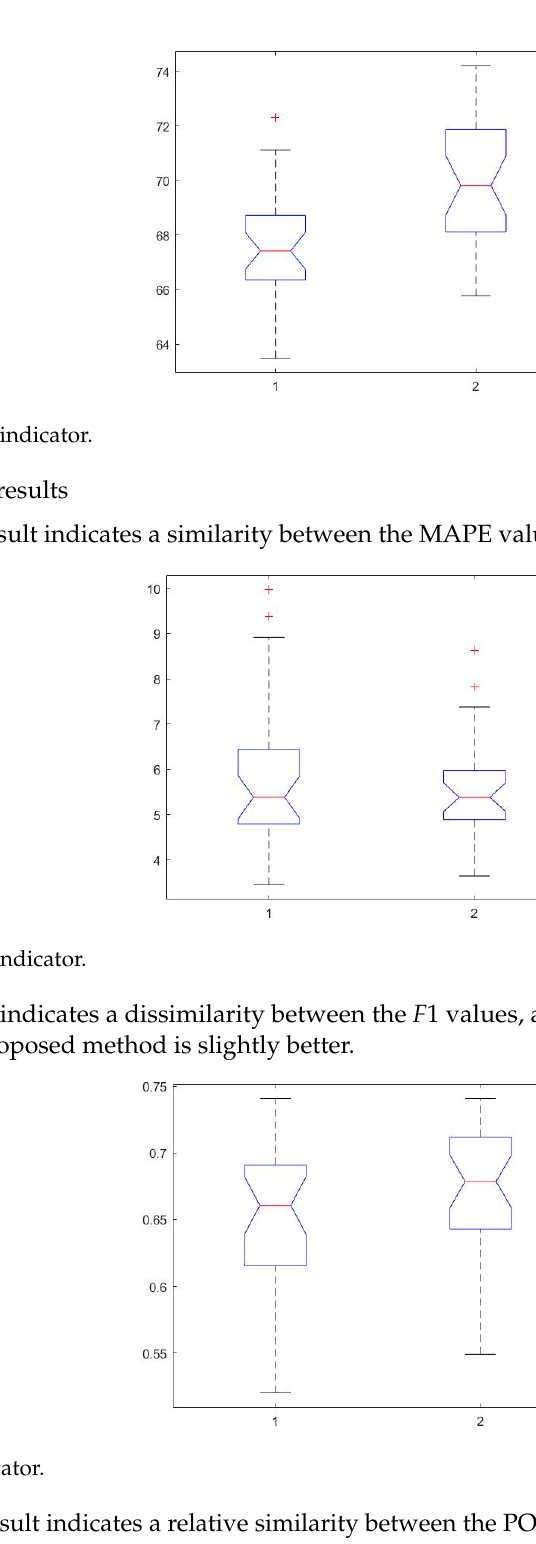
MAPE indicator. The result indicates a dissimilarity between the MAPE values, the one corresponding to the proposed method being far better. Figure 16. ANOVA test, MAPE indicator. 2. F 1 indicator. The result indicates a dissimilarity between the F 1 values, the one cor- responding to the proposed method being far better.